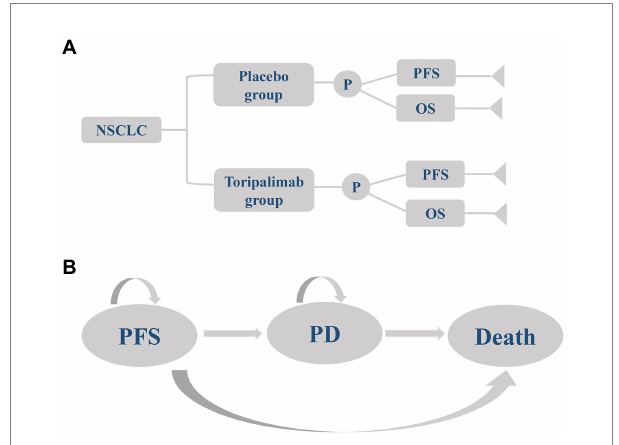
FIGURE 1 A three-state partitioned survival model simulating advanced non- small cell lung cancer. (A) Decision tree and (B) Graph of the partitioned survival model. NSCLC, non-small cell lung cancer; placebo group, placebo + chemotherapy; toripalimab group, toripalimab + chemotherapy; PFS, progression-free survival; PD, progressive disease; OS, overall